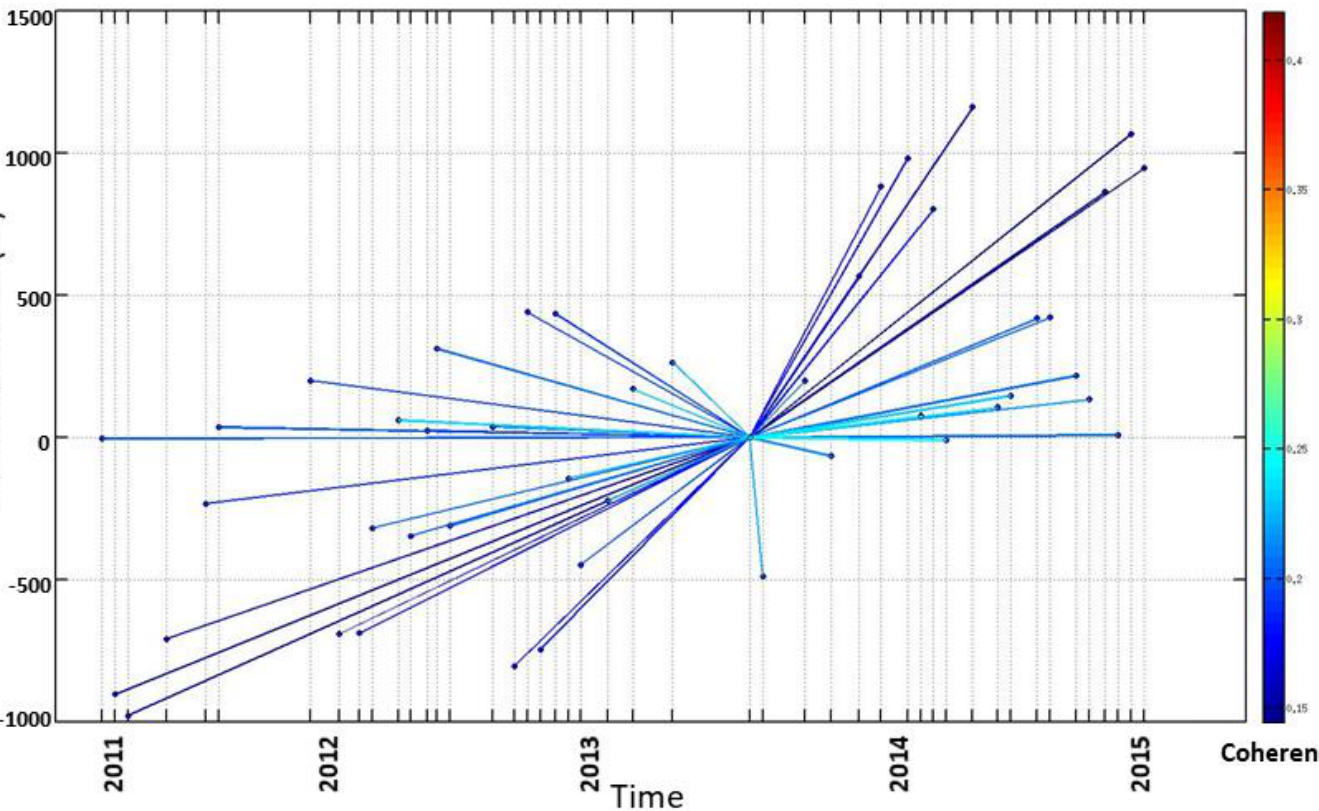
Figure 4 . Graph used to connect images related to the temporal baseline (X axis) and normal baseline (Y axis). Every dot represents an image, whereas every line represents an interferogram. Colours from blue to red show an increasing value of the spatial coherence.